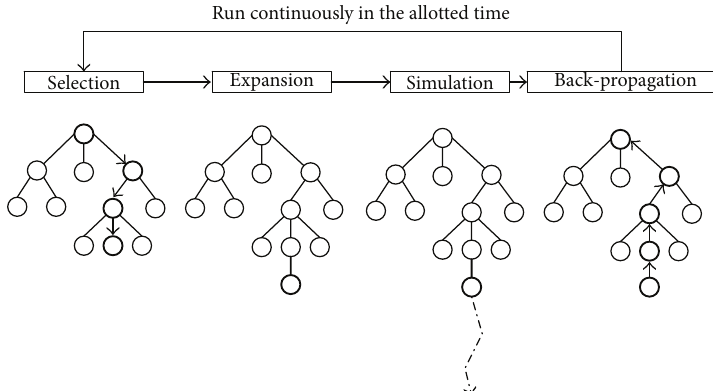
Figure 1: Four steps of the Monte-Carlo Tree Search